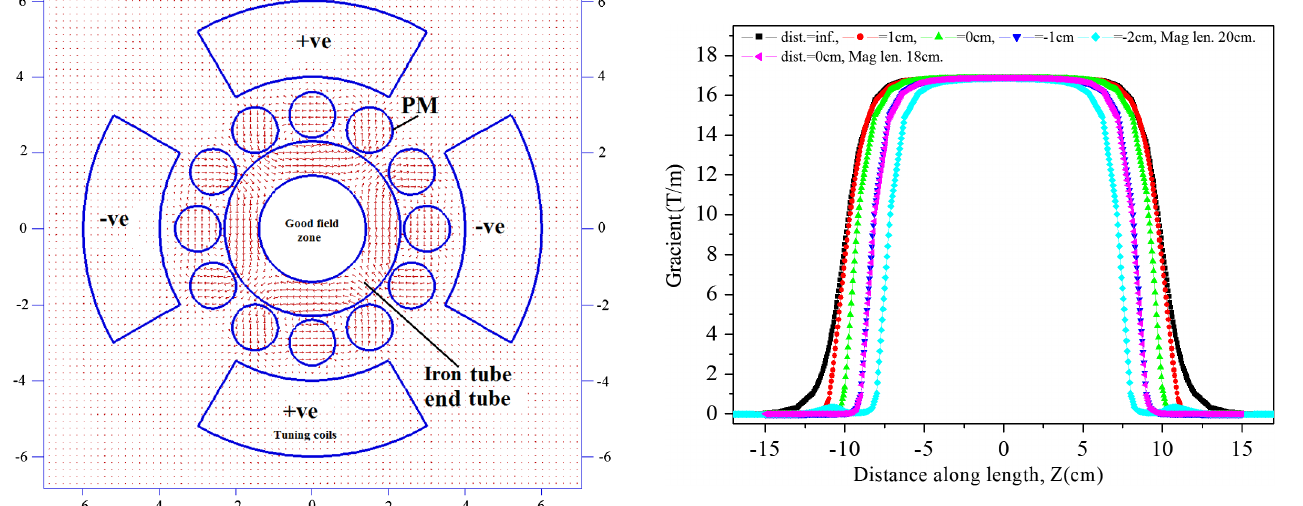
FIG. 12. Variation of the gradient along the length of the magnet of 20 cm length in the presence of end tubes. The distances of each end tube from the edge of the magnet are inf, 1, 0, − 1 , and − 2 cm, respectively. The gradient for 18 cm magnet length and each end tube placed at the edge is also